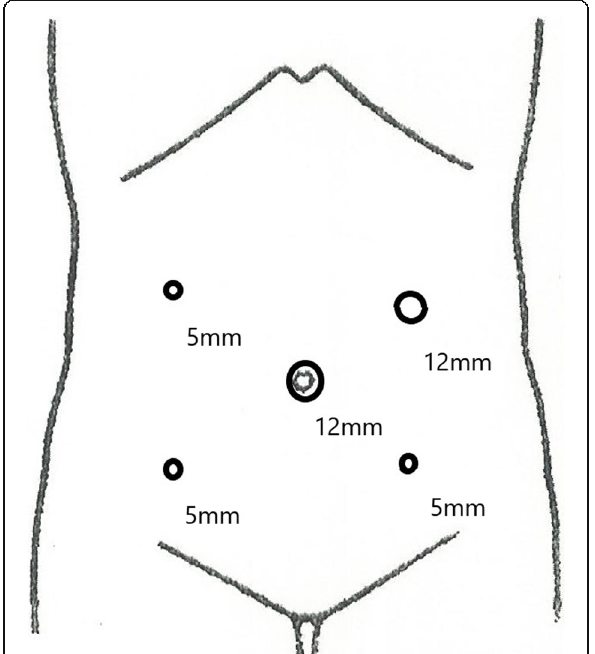
Fig. 1 Port placement during conventional laparoscopic ileocecal resection